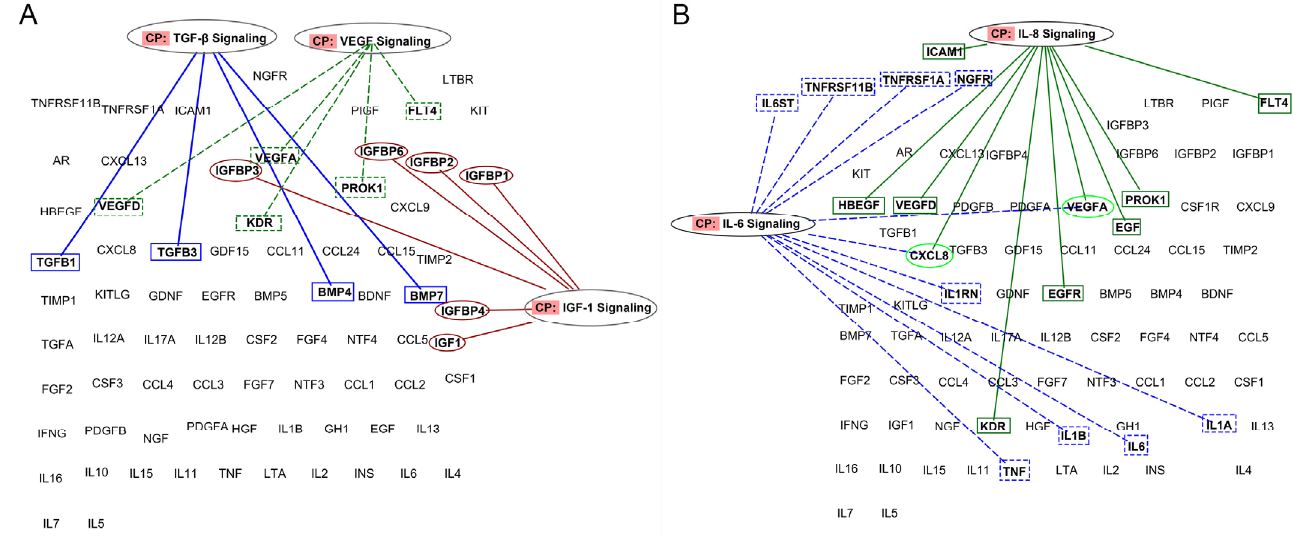
Figure 3. Representation of proteins involved in specific inflammatory and angiogenic pathways and their connections. ( A ) PRP actions should not be attributed to a single growth factor but to the interplay in PRP signaling networks ( B ) IL-8 and IL-6 signaling networks within plasma formulations (figures were created using Ingenuity Pathway Analysis (IPA), QIAGEN). J. Clin. Med. 2022 , 11 , x FOR PEER REVIEW